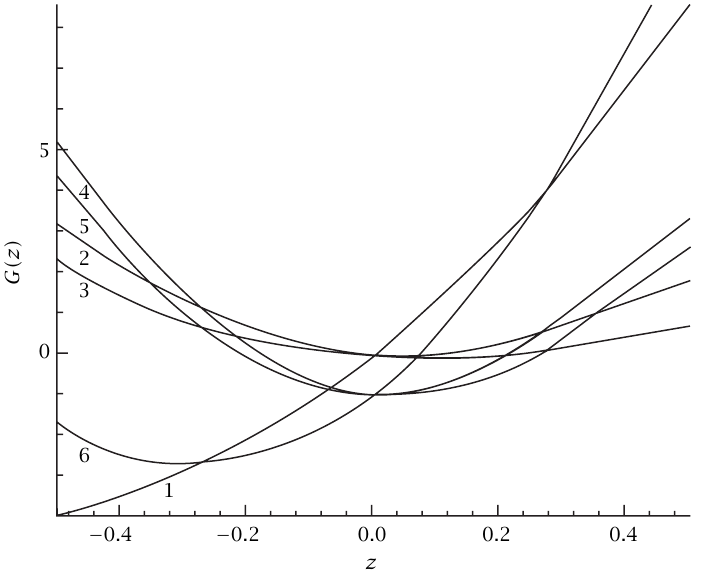
Figure 1.2 . The gravity function G(z) versus z for G 2 > 0. Each curve is labeled by a number given just below the curve. The curves 2, 3, and 1 are for G 2 = 8 . 5 and correspond, respectively, to G 1 = − 5 / 3, 0 . 0, and 12 . 0. The curves 4, 5, and 6 are for G 2 = 20 . 0 and correspond, respectively, to G 1 = − 5 / 3, 0 . 0, and 12 .